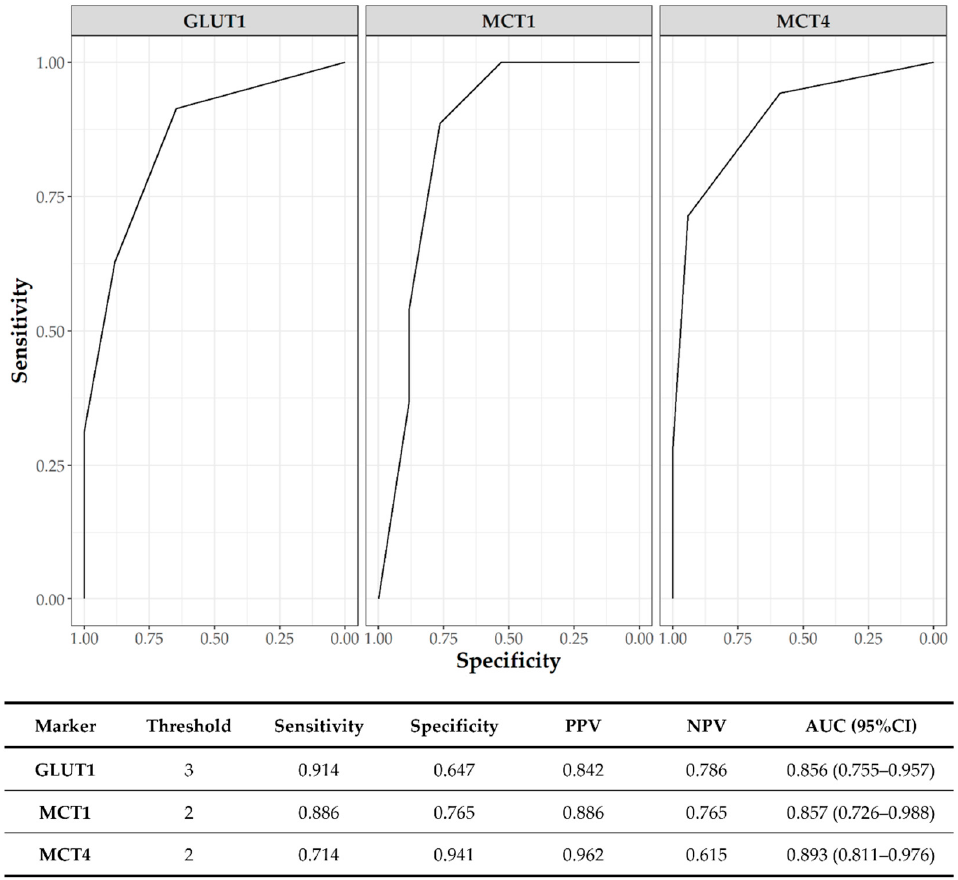
Figure 7. ROC curve analysis for SE vs. EC discrimination; PPV: positive predictive value; NPV: negative predictive value; AUC: area under ROC curve; CI: confidence interval .